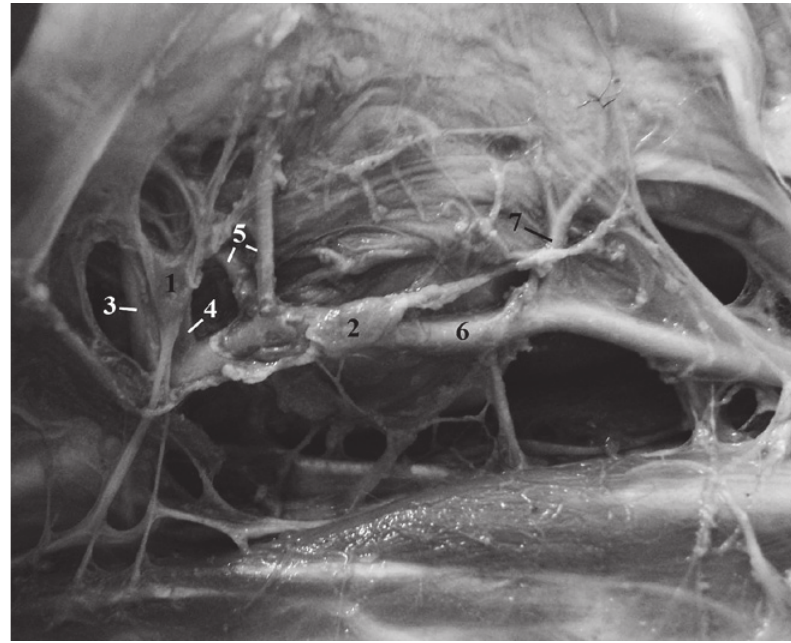
Fig 4 - Photomacrography of left side of a S. niger we can see the celiac mesenteric ganglion (1) , round the origin of celiac (3) and mesenteric cranial (4) arteries and the mesenteric caudal ganglion (2) located caudally the origin of kidney arteries (5) , laterally the abdominal aorta (6) and cranial to the mesenteric caudal artery (7)